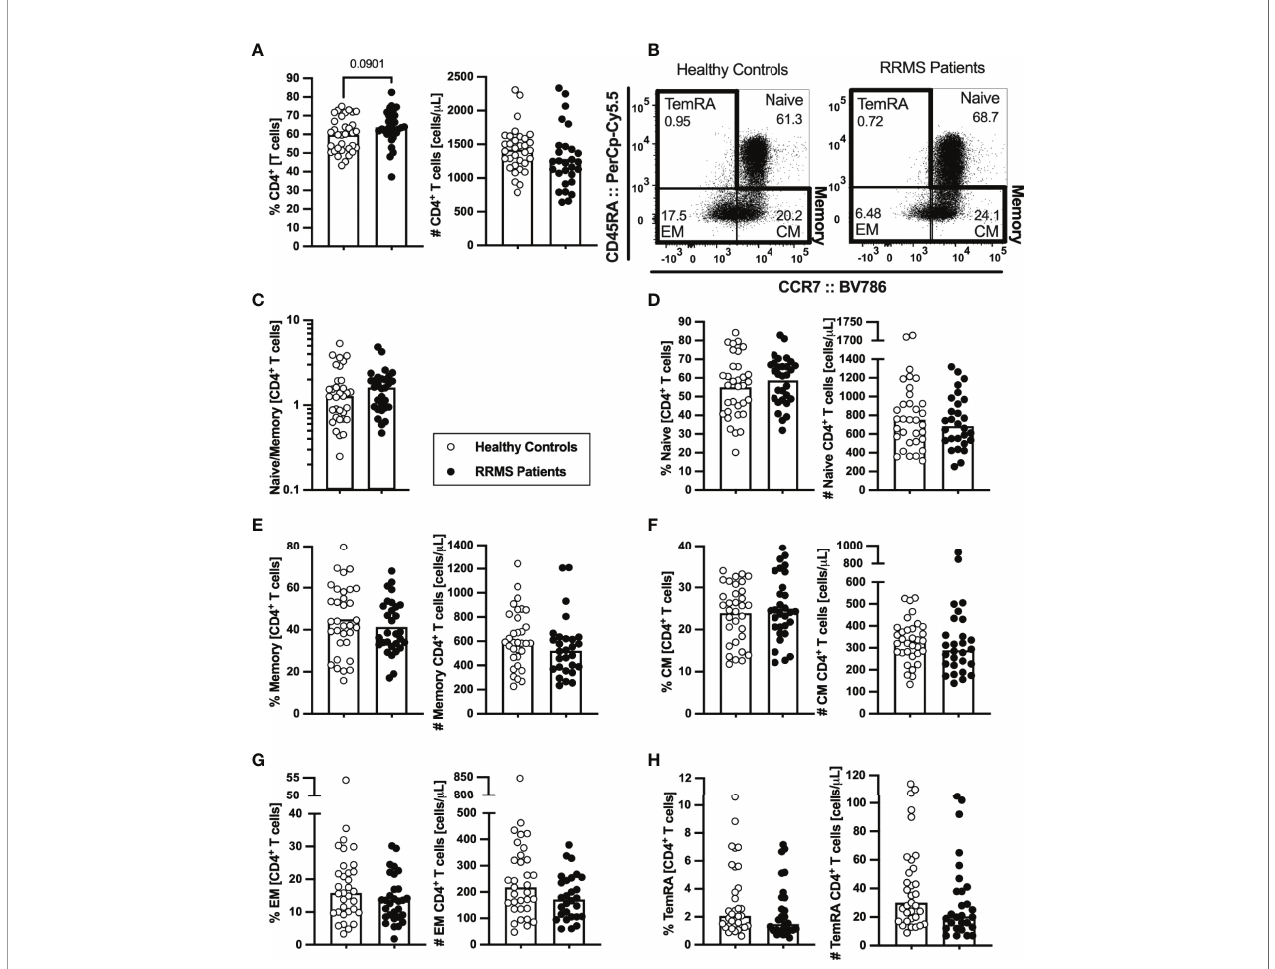
FIGURE 2 | Newly diagnosed RRMS patients present no major differences on CD4 + T cells subsets. Percentages and numbers of CD4 + T cells are represented for healthy controls (white circles) and newly diagnosed RRMS patients [black circles; (A) ]. Representative dot plots of the CD4 + T